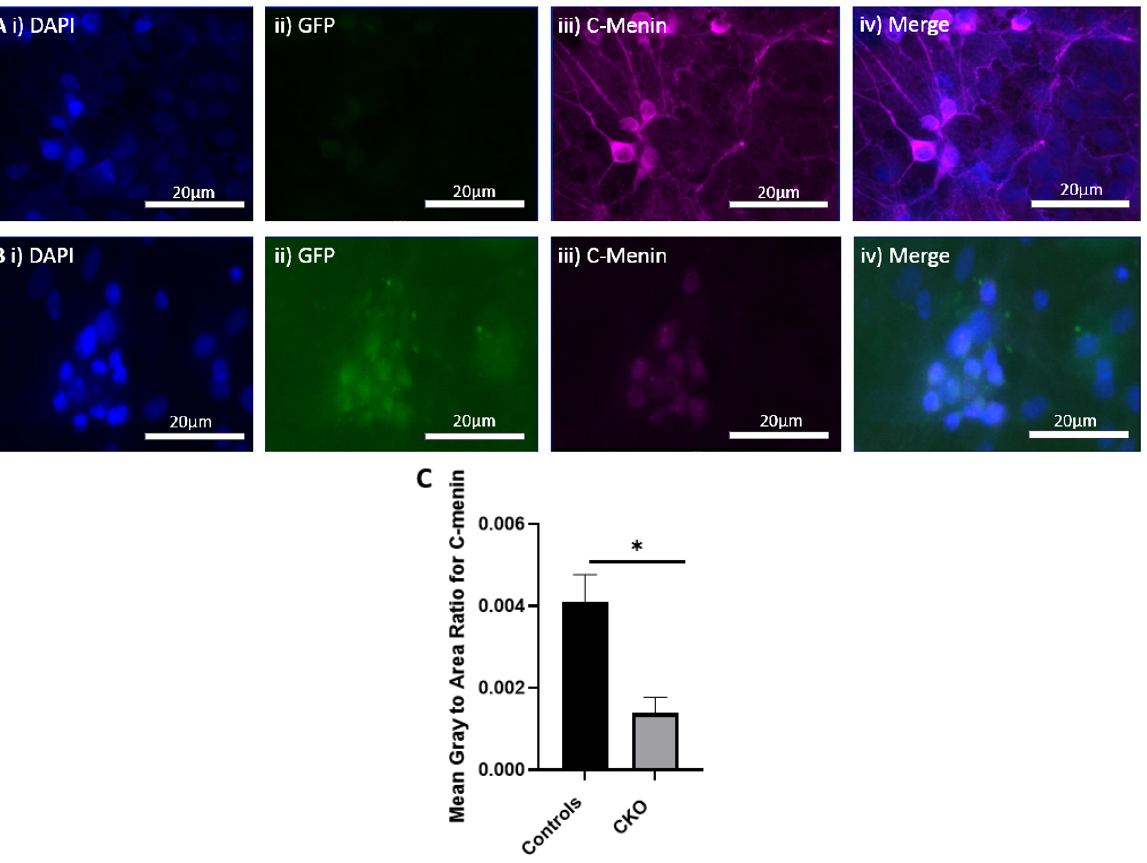
Figure 2. The transduction of hippocampal neuronal cultures from the MEN1 floxed mice with the virus, pNN.AAV.hSyn.HI.eGFP-Cre.WPRE.SV40. ( A ) Controls with no virus; ( i ) GFP signal in the absence of virus; ( ii ) DAPI for nuclear staining; ( iii ) merge with GFP and DAPI; ( B ) CKO with virus transduction by Cre AAV9; ( i ) GFP signal indicating virus transduction in the preparation with the Cre AAV9; ( ii ) DAPI for nuclear staining; ( iii ) merge with GFP and DAPI showing overlap in the neurons expressing GFP and DAPI.